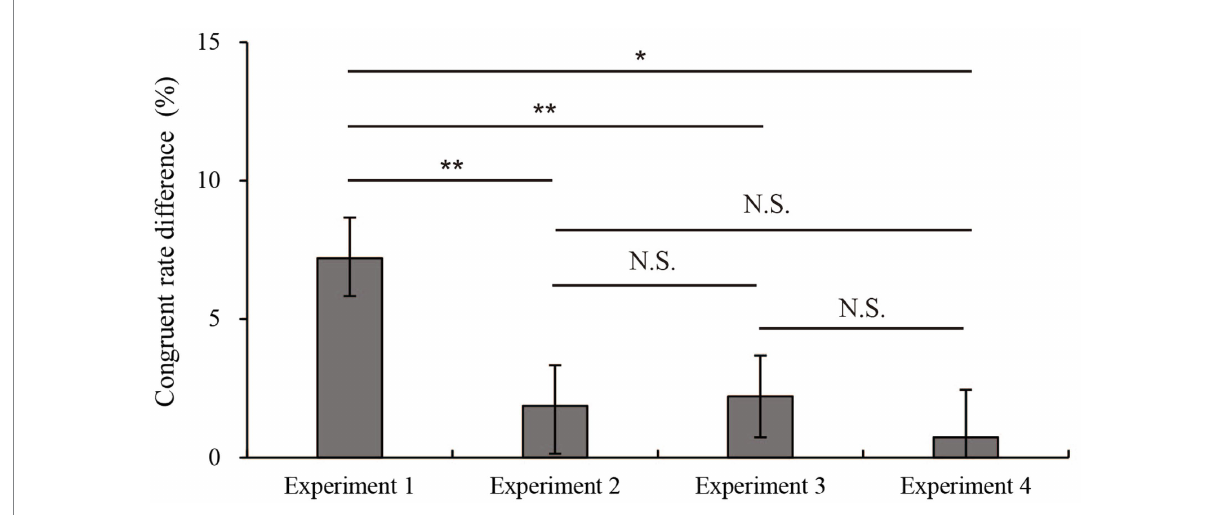
FIGURE 6 Mean differences in the congruence rates between the pre-test and post-test in Experiments 1–4. Error bars show the standard errors of mean. *** p < 0.001. ** p < 0.01. * p < 0.05. N.S. indicates a nonsignificant